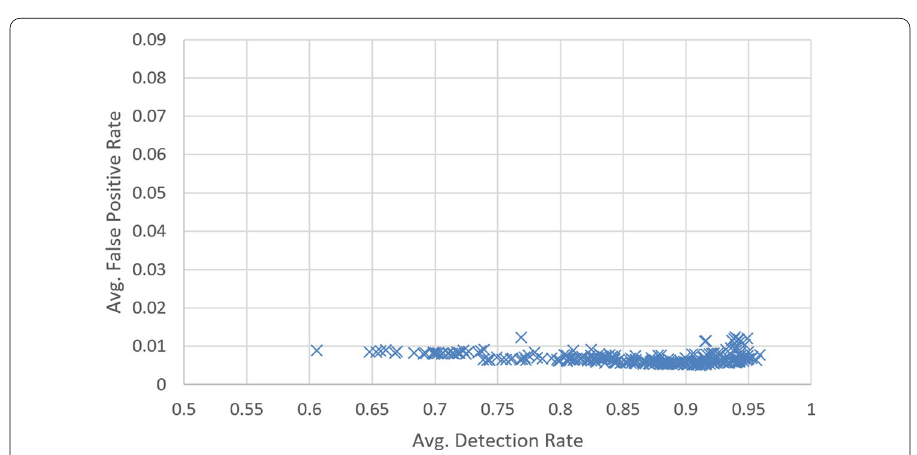
Fig. 9 Training performance of the proposed approach for DATASUBSET3